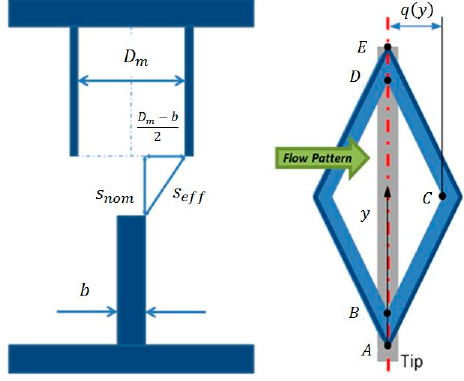
Figure 5. Nominal and effective